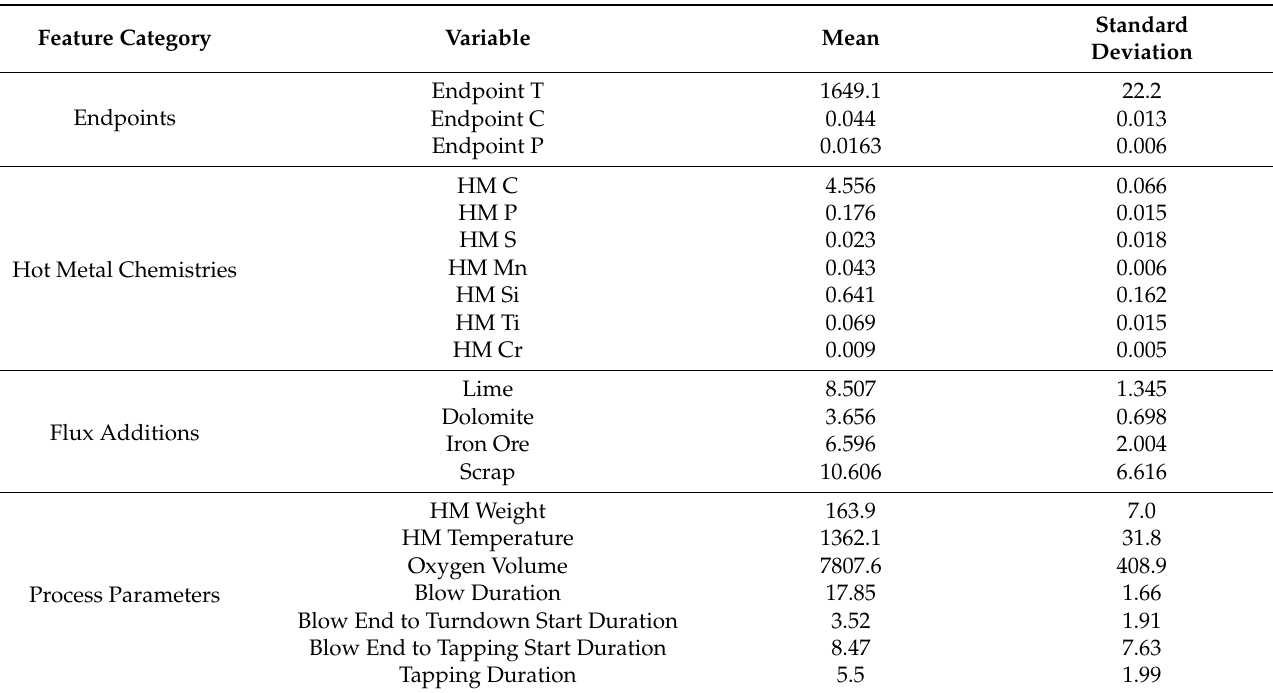
Table 1. Descriptive statistics of features and endpoints for Tata Steel